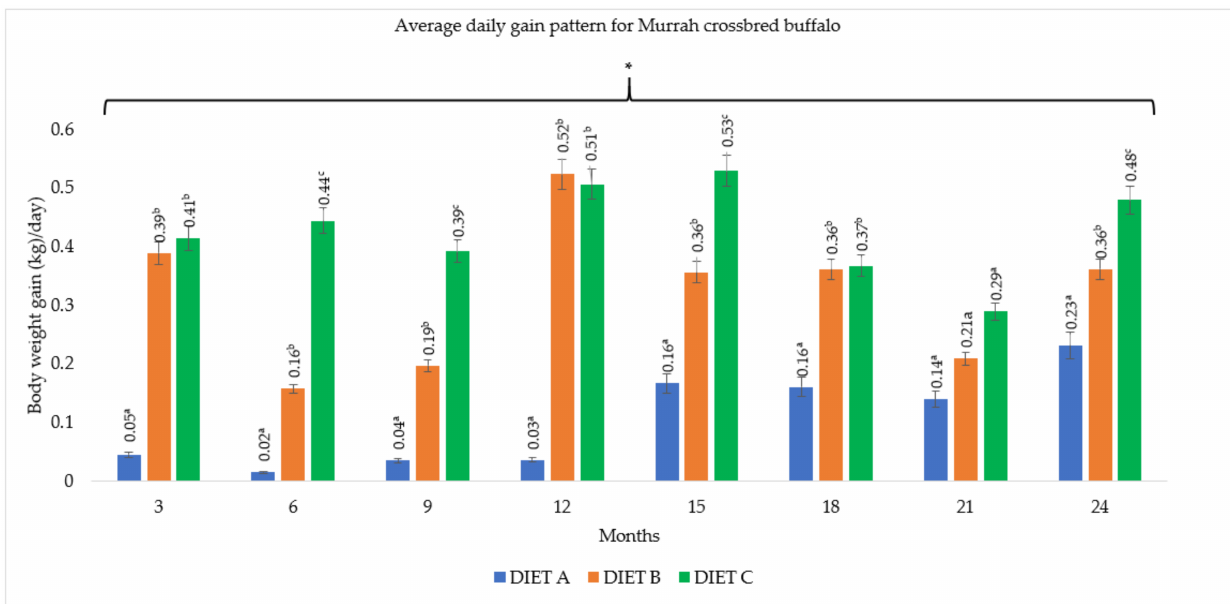
Figure 5. The average daily gain pattern at three-month intervals for Murrah crossbred buffaloes. Diet A (control)—(100% Brachiaria decumbens) ; Diet B—(70% Brachiaria decumbens + 30% concentrate); Diet C—(70% Brachiaria decumbens + 26% concentrate + 4% bypass fat); the values are presented as mean; a,b,c different superscripts indicate significant difference of average daily gain pattern for Murrah crossbred buffalo at p < 0.05; * indicating significant ( p < 0.05) difference comparing body weight gain and